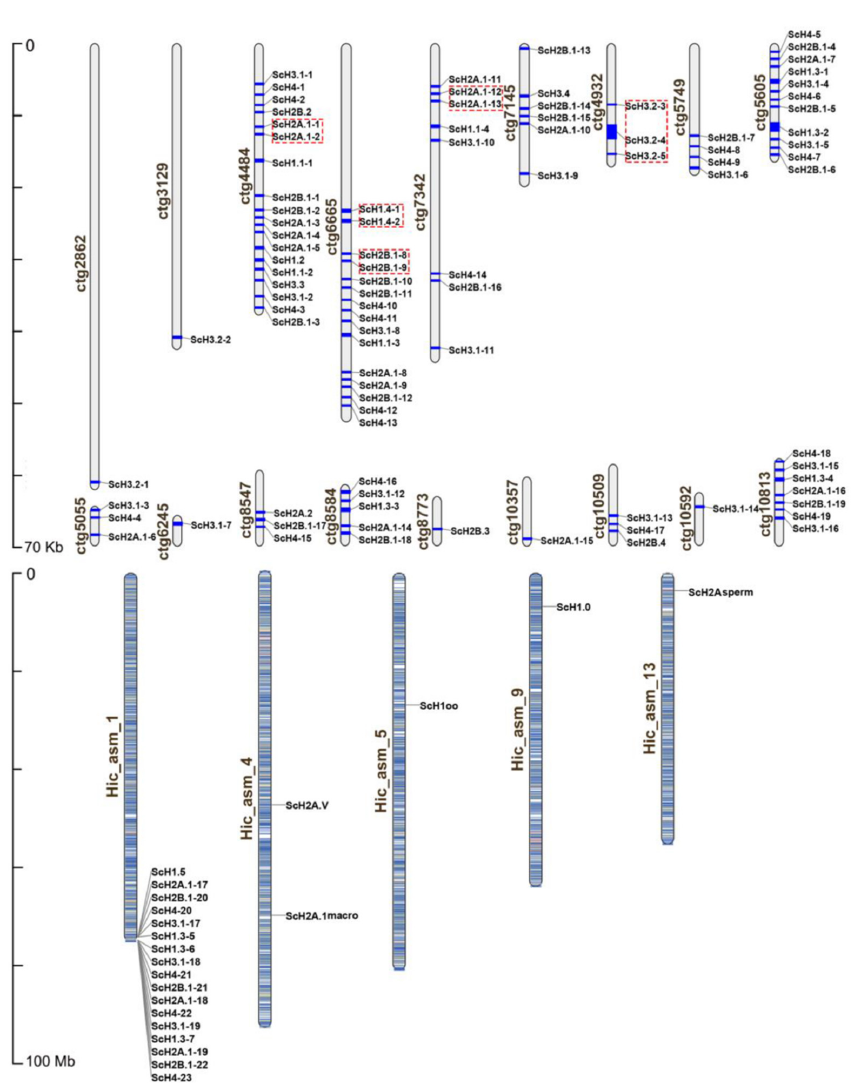
Figure 1. Chromosomal distribution of the S. constricta histone genes. The gene names on the right side of each chromosome and scaffold correspond to the approximate locations of each histone gene. Tandemly duplicated homologs are marked by red boxes. Ctg means scaffolds that are not mapped on chromosomes, while Hic_sam means chromosomes.